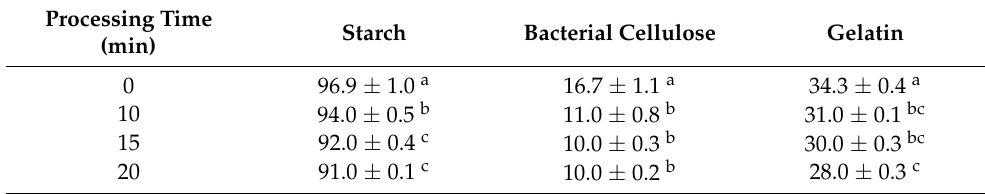
Table 5. Solubility of the starch, bacterial cellulose, and gelatin films treated with dielectric barrier discharge plasma at an optimal excitation frequency (50 Hz for the starch film and 900 Hz for the bacterial cellulose and gelatin films) without Mylar™ support. For each property, values followed by at least one common letter are not different from each other ( p >